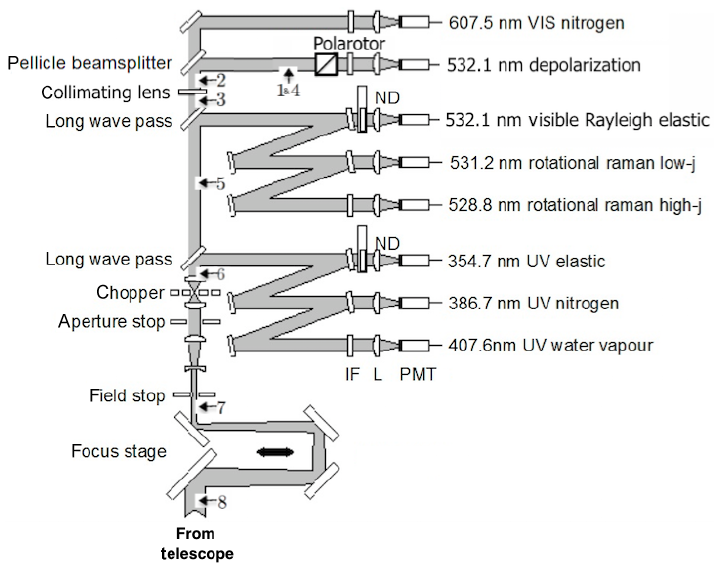
Figure 1. Diagram of CRL’s receiver system, showing all seven existing measurement channels plus the newly installed depolarization hardware. The new hardware consists of the pellicle beam splitter, the Polarotor, and the interference filter, focusing lens, and PMT, to the right of the Polarotor. Numbers correspond to calibration test numbers from Table 1 and indicate the test locations of the depolarizing sheet used in those tests. The number “7” also marks the location of the calibration cube polarizer added to the system for the calibrations in Sect. 5.1, and “8” is also the location of the lamp and depolarization sheet during the polarized light tests in that section. During regular lidar sky measurements, neither the depolarizing sheet nor the calibration cube polarizer remain in the optical path. This figure is based on Fig. 2 of Nott et al.